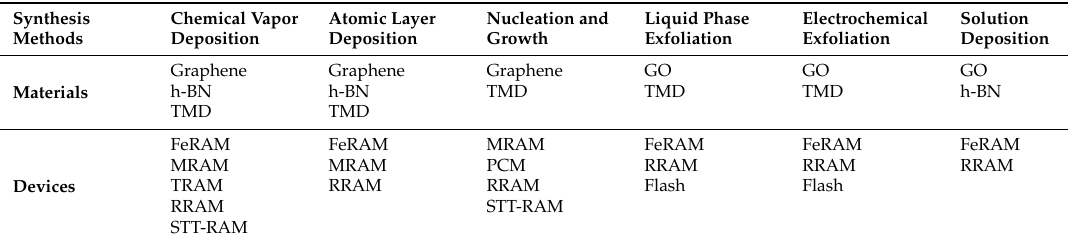
Table 1. Comparison among main synthesis technologies and applications for graphene and its derivatives